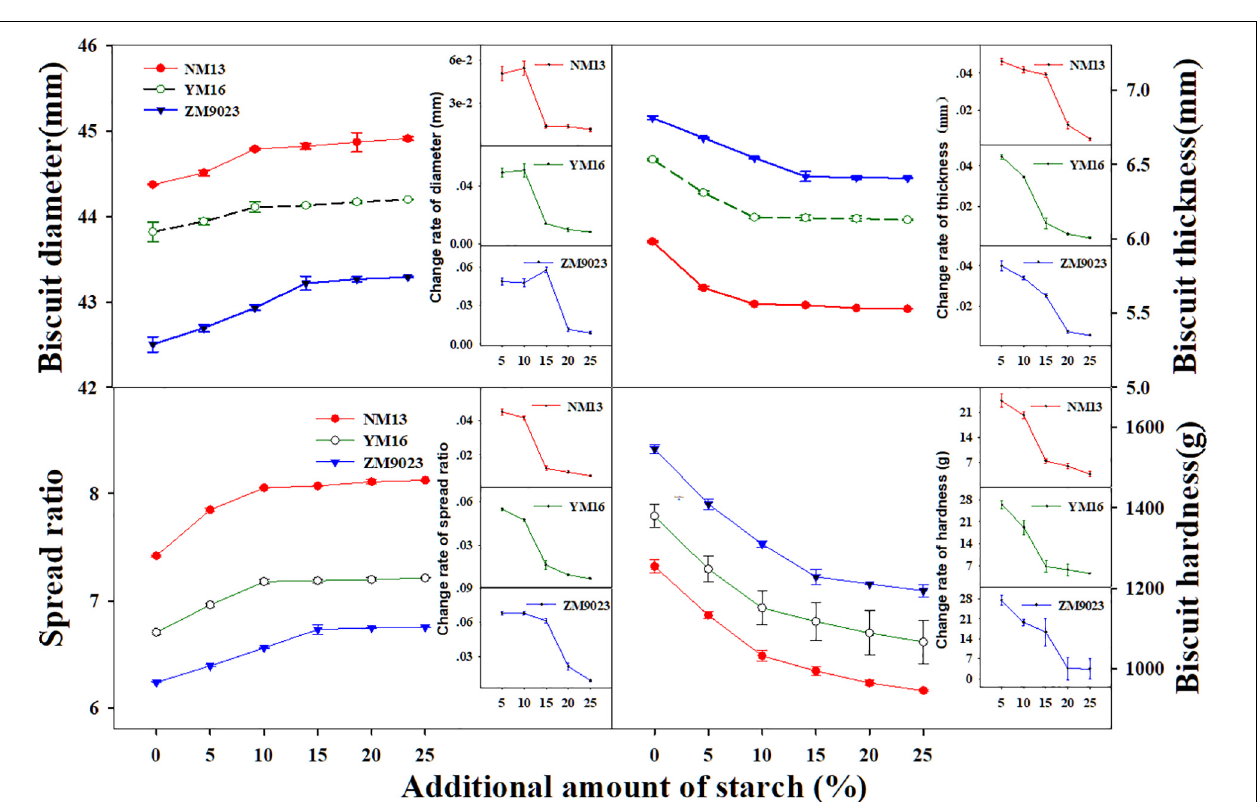
Frontiers in Plant Science |